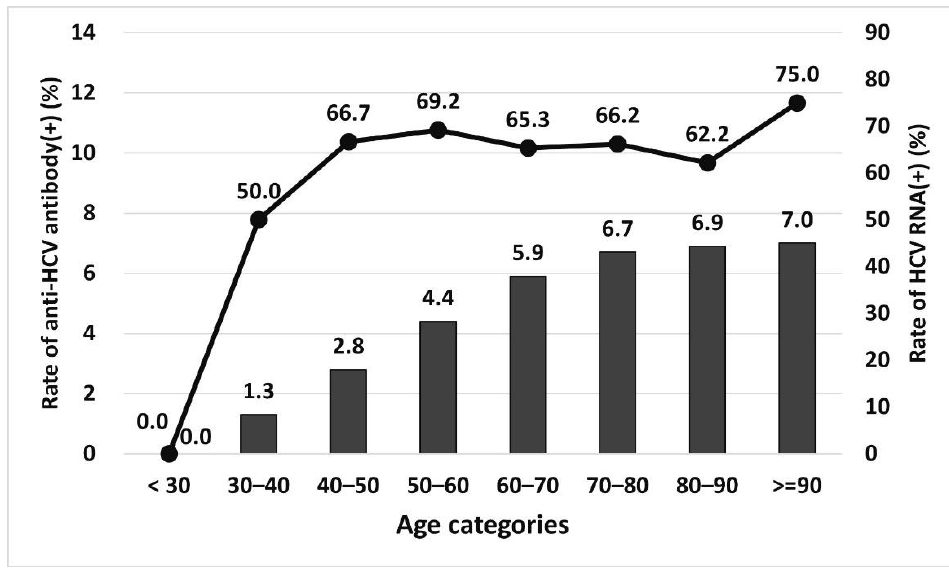
Figure 4. The prevalence of seropositive HCV antibody and HCV viremia in each age category.